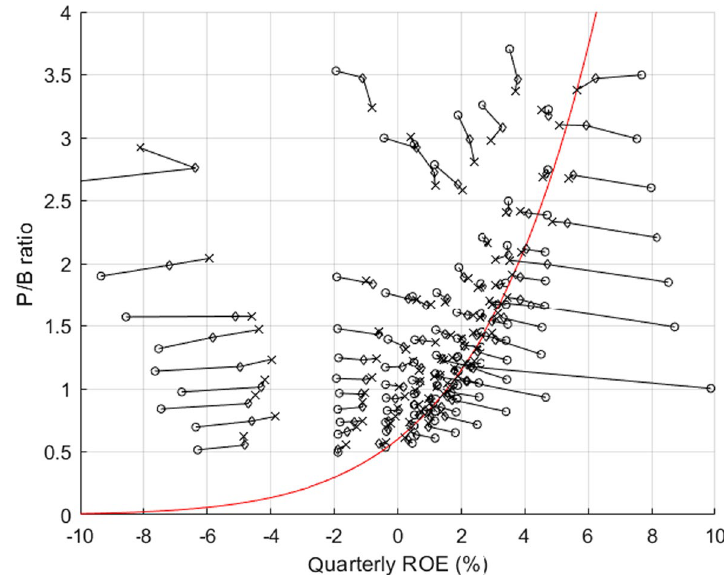
Fig. 26 Three‑view drawing: the relationshiep between ROE and P/B (circle, diamond, x‑mark: the data in the t, t 1, t 2 Quarter) + +